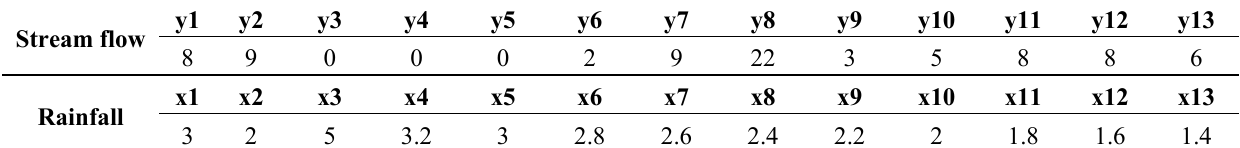
Table 6. An example of count tau and stream flow influence rainfall over time. Stream